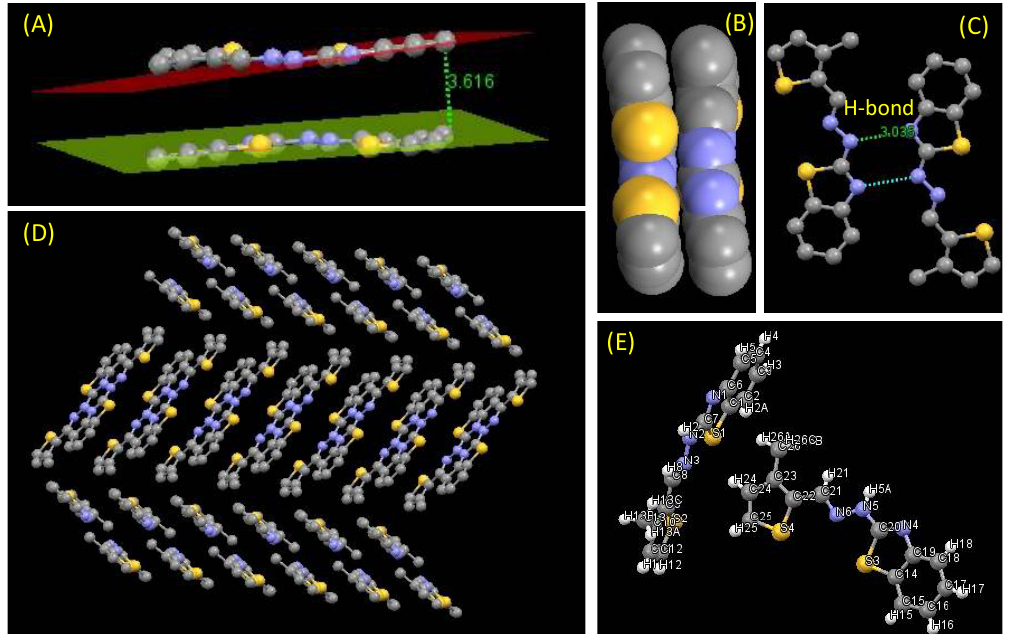
Figure 3. ( A ) Two adjacent molecules showing the π-π stacking interaction also displayed with the help of ( B ) the space fill model, ( C ) H-bonding interaction between two laterally close molecules (bond length shown in Å), ( D ) extended network of molecules though weak interactions (π-π stacking and H-bonding), and ( E ) labeling of each atom shown in ball stick model.